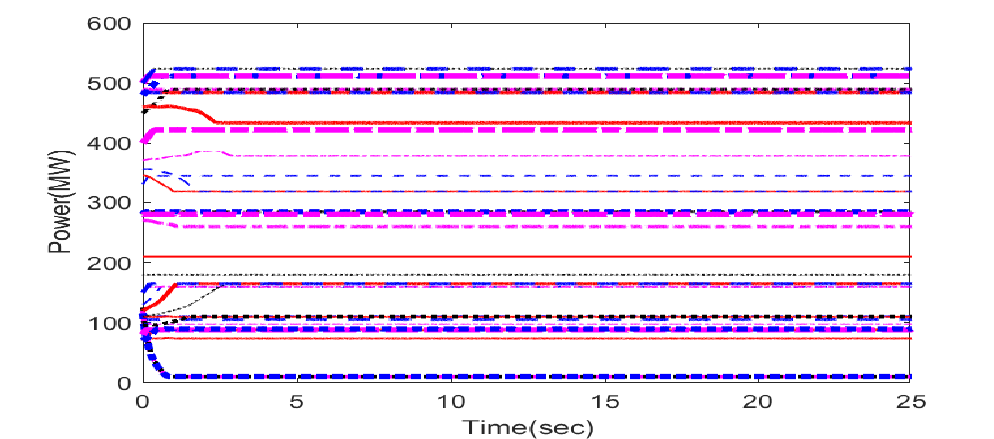
Figure 10. Individual power generation of forty units.